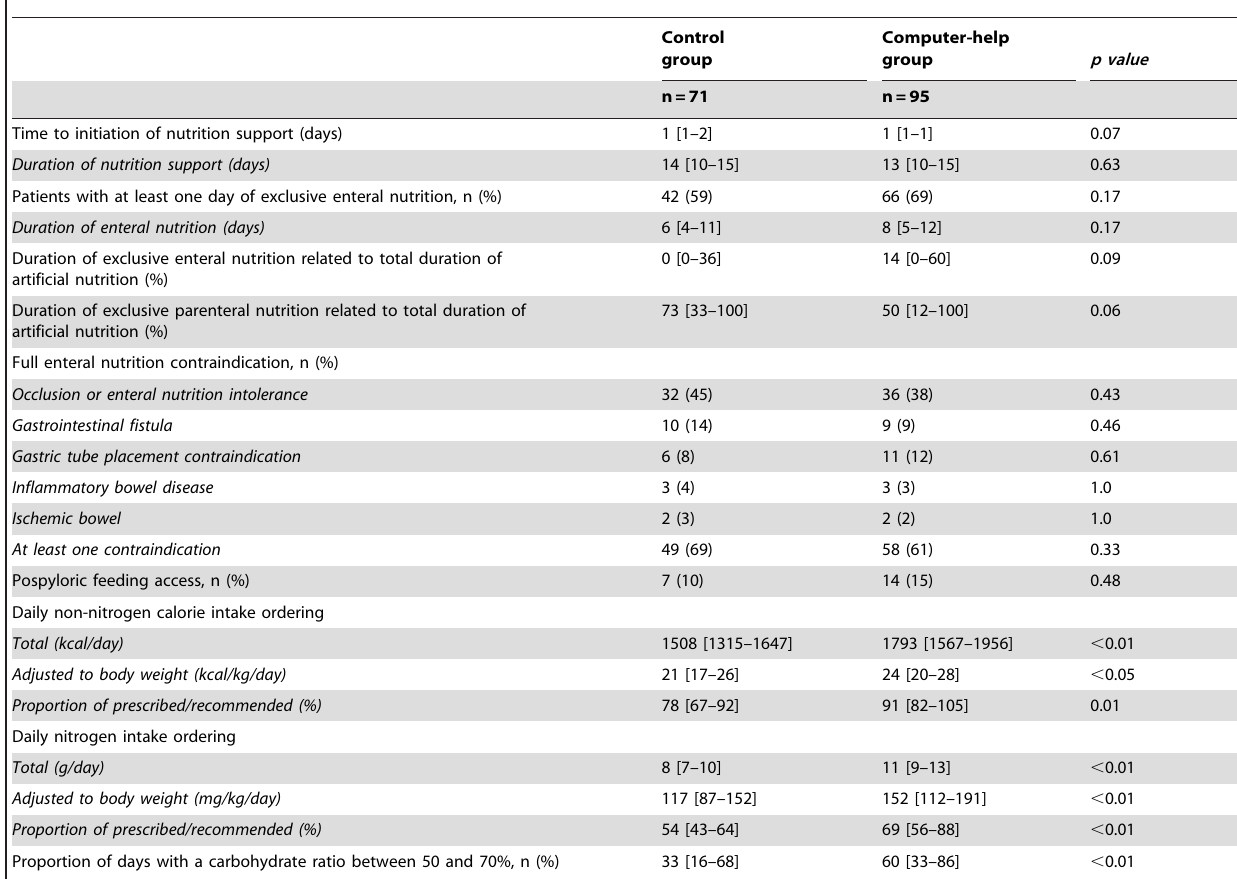
Table 2. Characteristics of nutritional support during the first 15 days of ICU stay.